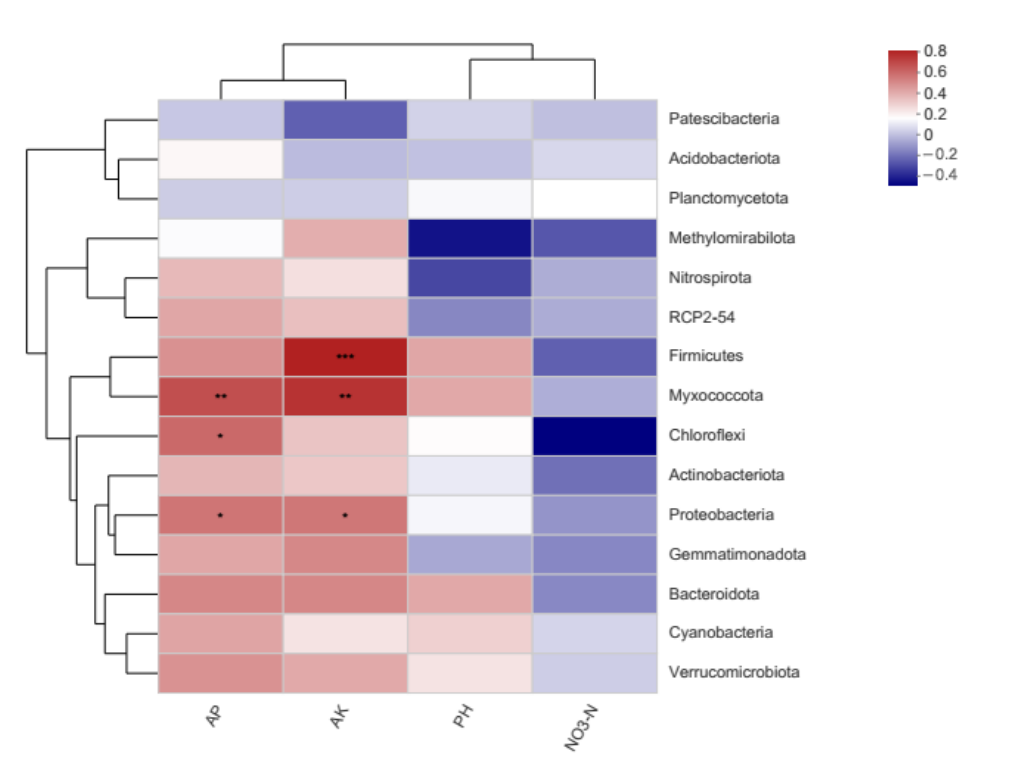
Figure 5. RDA of soil bacterial community structure associated with soil properties (* P <0.05; ** P <0.01; *** P <0.001).